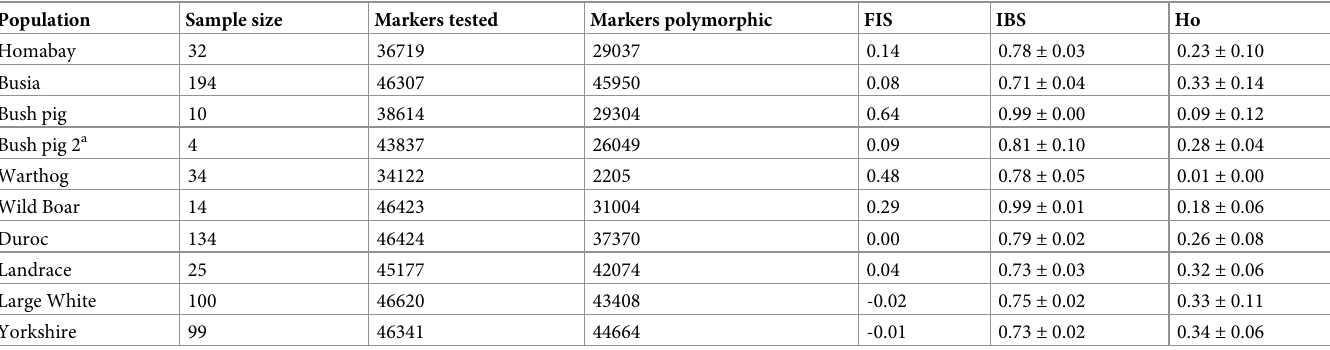
Table 2. Observed heterozygosity (Mean ± SD) in various pig groups evaluated. Population